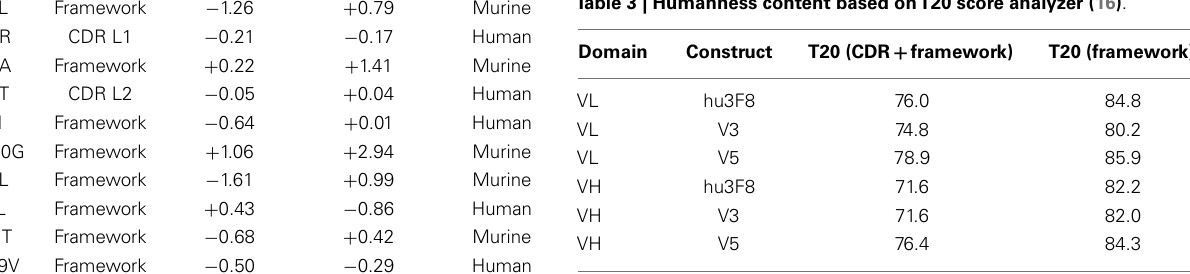
Table 3 | Humanness content based onT20 score analyzer (16)